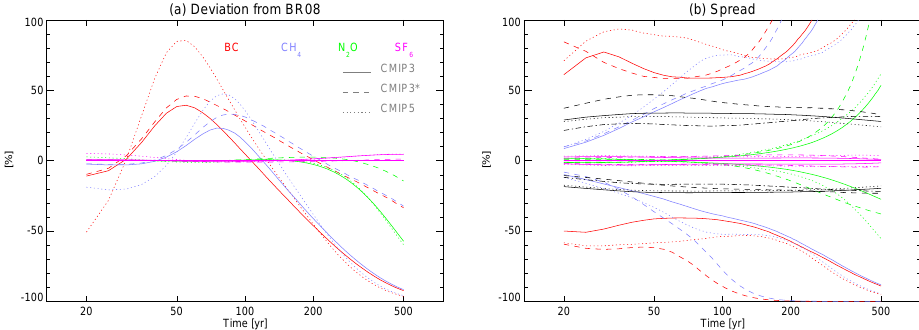
Fig. 5. Impact of variation in IRF T on GTP for BC (red), CH 4 (blue), N 2 O (green), and SF 6 (purple), using the CMIP3 (full line), CMIP3* (dashed line), and CMIP5 (dotted line) IRF T . (a) Difference between the median of the obtained metric distribution and the value obtained using the reference BR08 IRF T . (b) Spread of the obtained metric distribution, indicating the difference between the 5-percentile value and the median value (lower lines), and between the 95-percentile value and median value (upper lines). The black lines show the spread induced by IRF CO on GTP from C 4 MIP(u) (full line), C 4 MIP(c) (dotted line), LTMIP (dashed line), and J13 (dot-dashed line); these lines 2 are identical to the dashed lines in Fig.